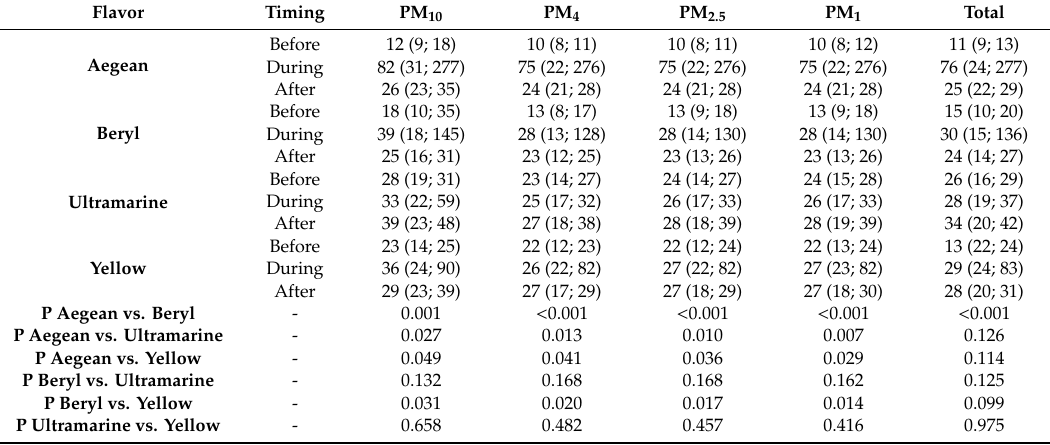
Table 2. Levels of particulate matter (PM), expressed as µ g / m 3 , comparing di ff erent flavors of Glo